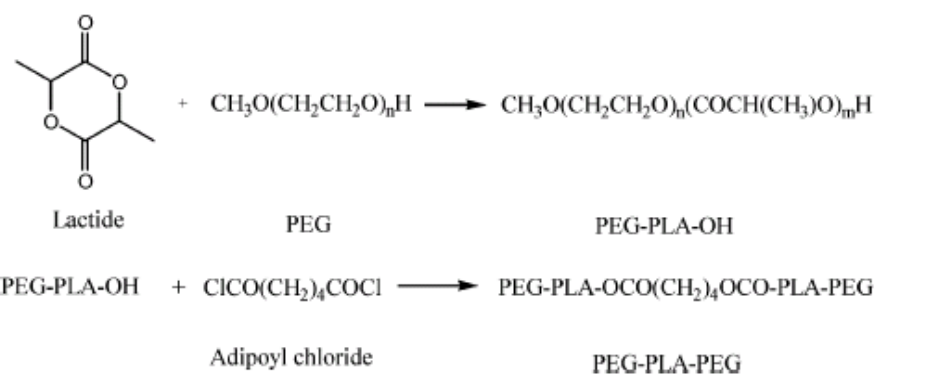
Figure 3. Synthesis of PEG-PLA-PEG in presence of monohydroxyethilated PEG followed by coupling PEG-PLA with Adipoyl Chloride